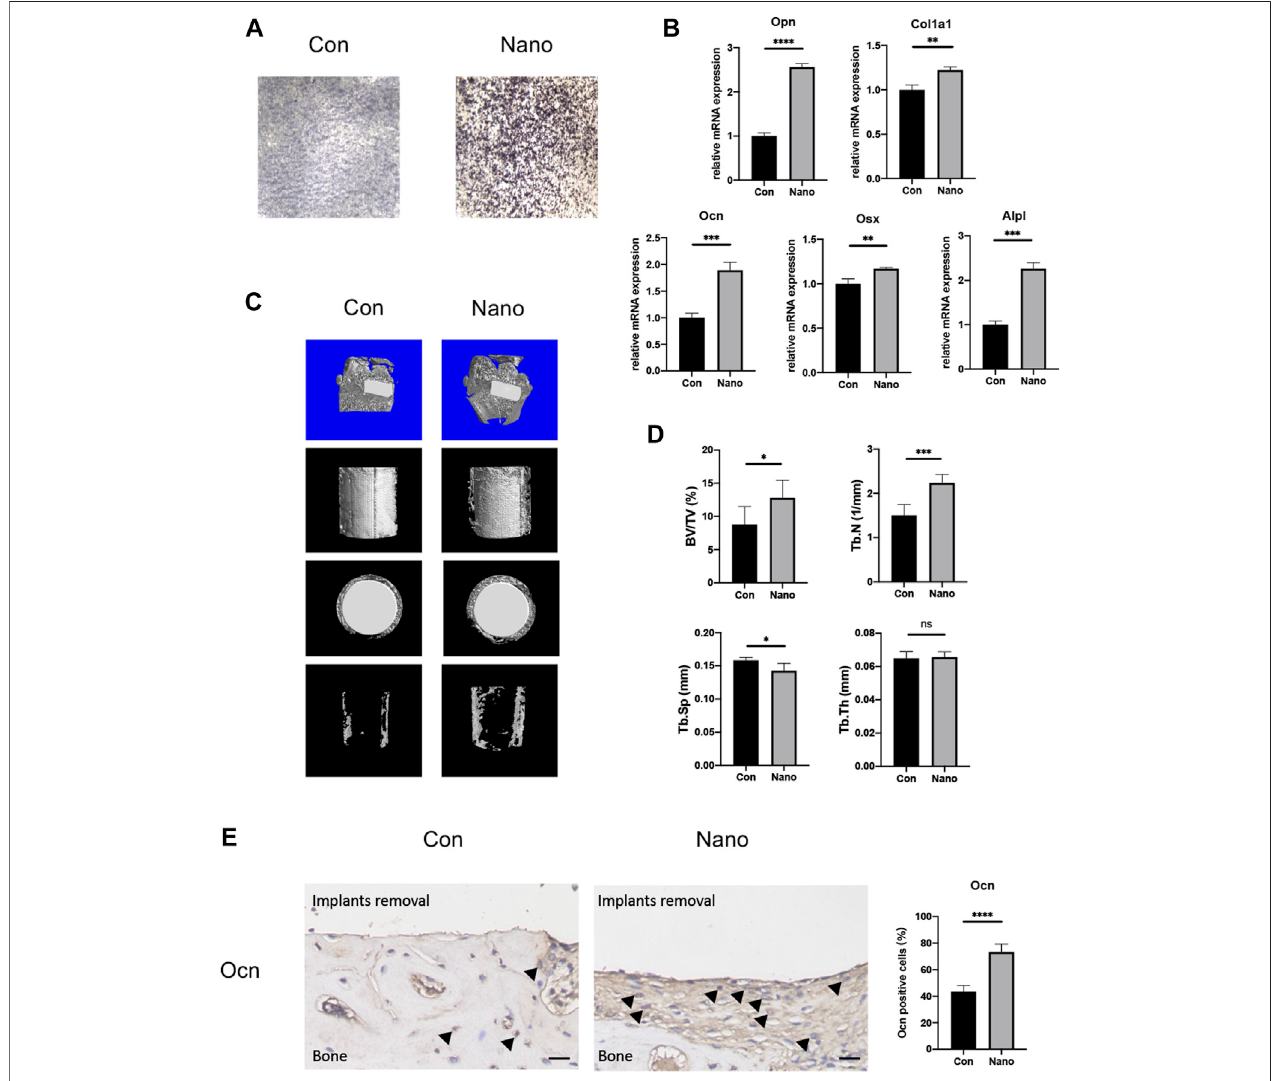
FIGURE 2 | Nanotopography promotes osteogenic differentiation of BMSCs both in vivo and in vitro . (A) ALP staining of BMSCs on different topographies. (B) Gene expression of osteogenic differentiation markers of BMSCs seeded on various topographies. (C) Micro-CT scans of the distal femur and presentative reconstruction of the new bone around implants from different views. (D) Analysis of BV/TV, Tb. N, Tb. Sp, and Tb. Th for new bones around implants with different topographies. (E) Immunohistochemistry staining and quantitative analysis of Ocn in new bones around implants. Scale bar: 10 μ m * p < 0.05, ** p < 0.01, *** p < 0.001, **** p <